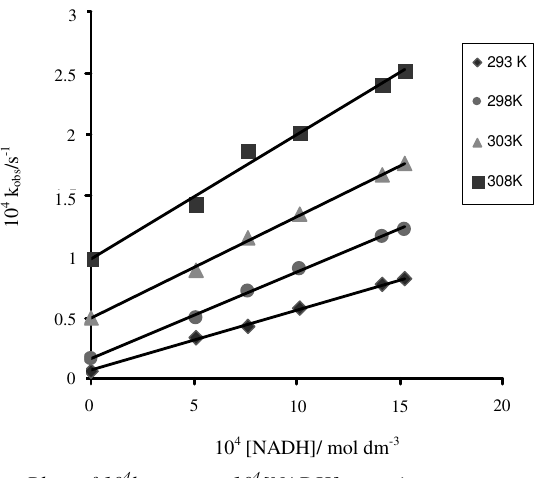
Figure 4. Rate dependence on